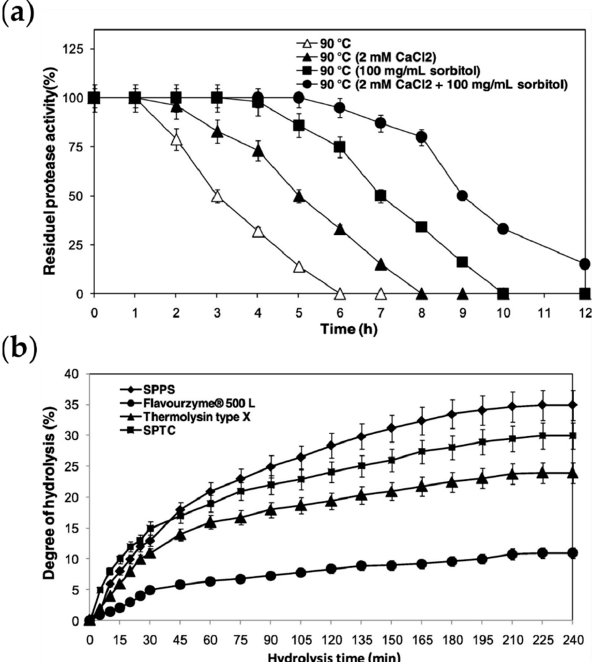
Figure 3 . A peptidase from Pleurotus sajor ‐ caju (SPPS) ( a ) showed remarkable temperature stability, which was improved through the addition of Ca 2 Cl and sorbitol. ( b ) SPPS showed improved hy ‐ drolysis of casein in comparison to other peptidases (SPTC: peptidase from Trametes cingulata, Fla ‐ vourzyme 500 L: commercial peptidase mix from Aspergillus oryzae, Thermolysin type X: commer ‐ cial peptidase from Geobacillus stearothermophilus). Reprinted from